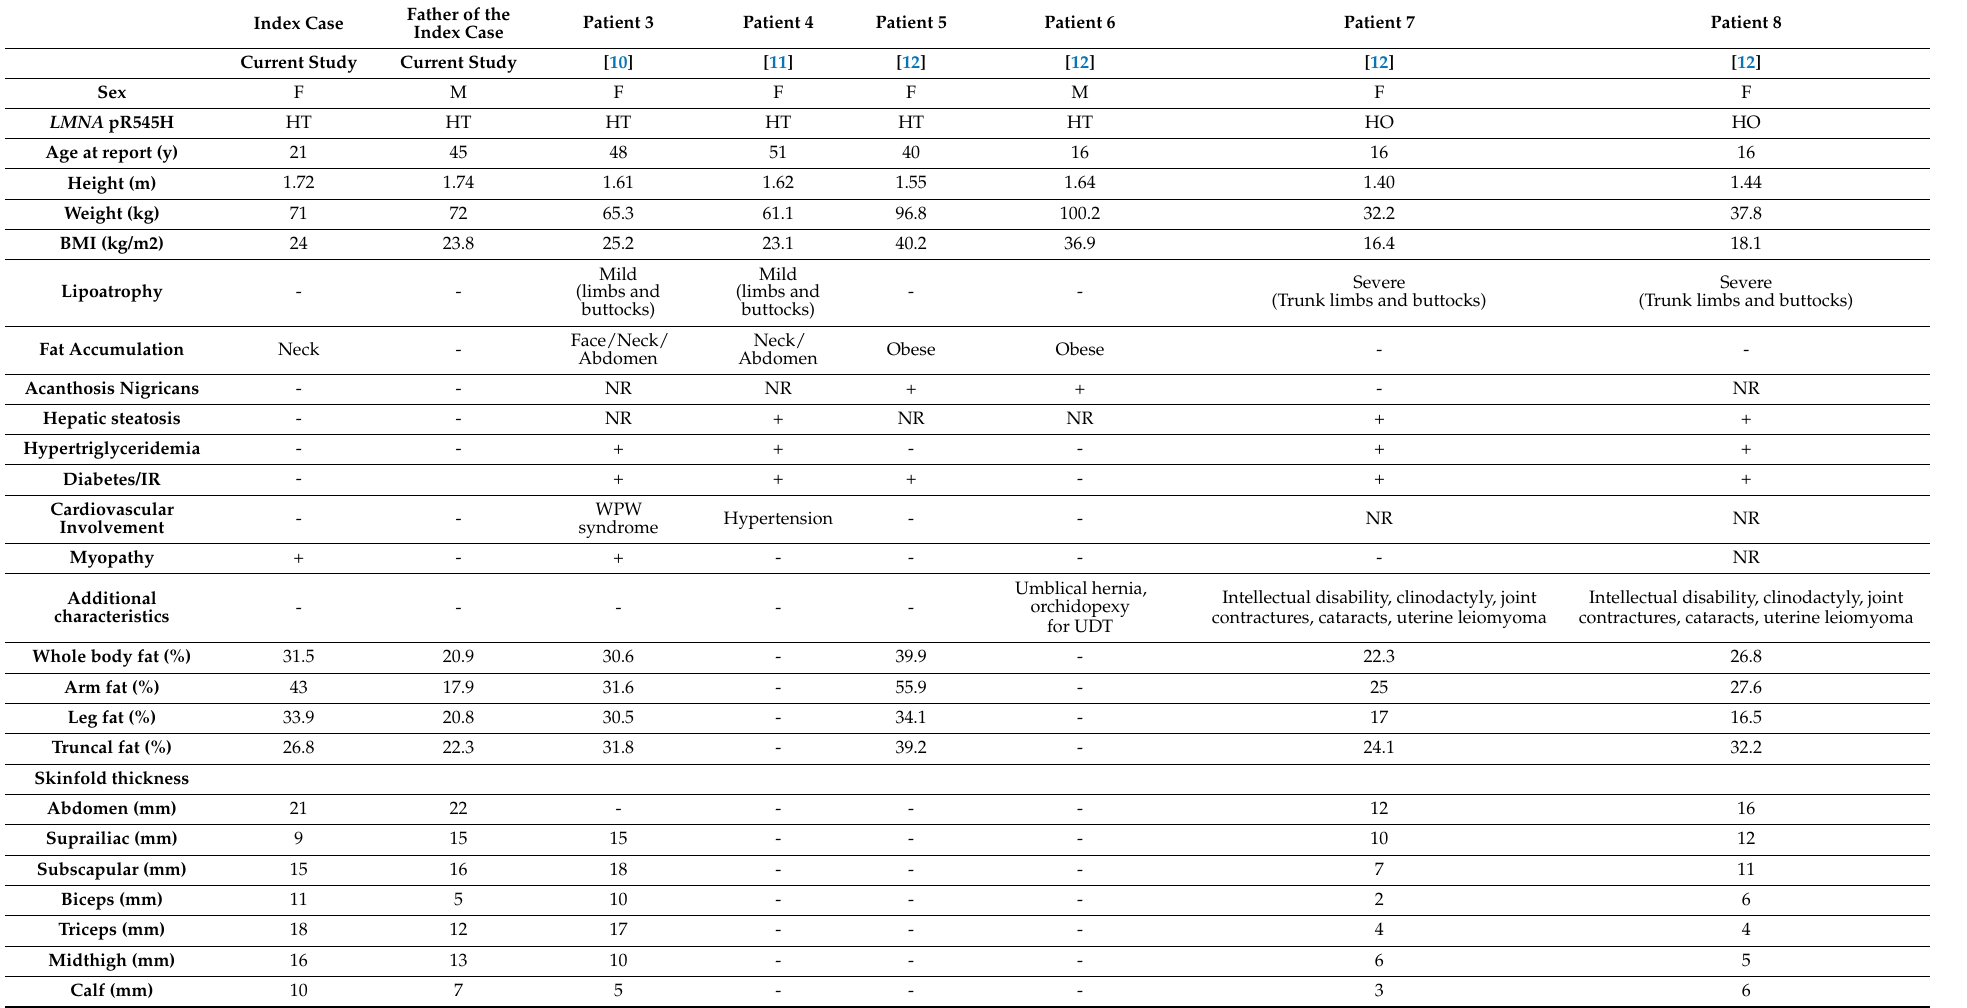
Table 1. Clinical features of our index case patient with heterozygous LMNA p.R545H variant compared with previously published